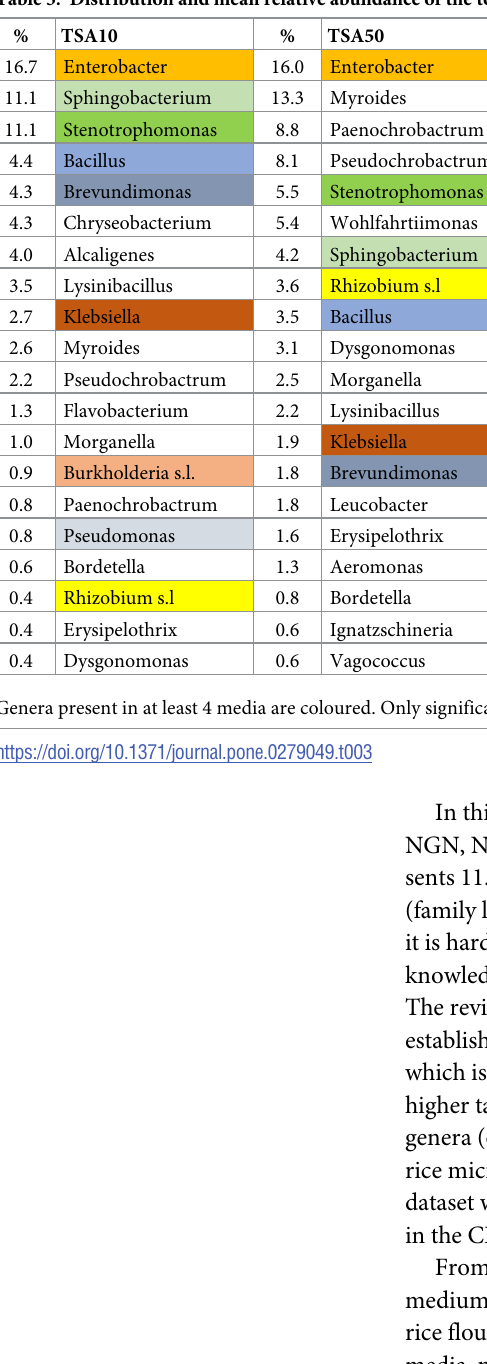
Table 3. Distribution and mean relative abundance of the top 20 genera detected in the